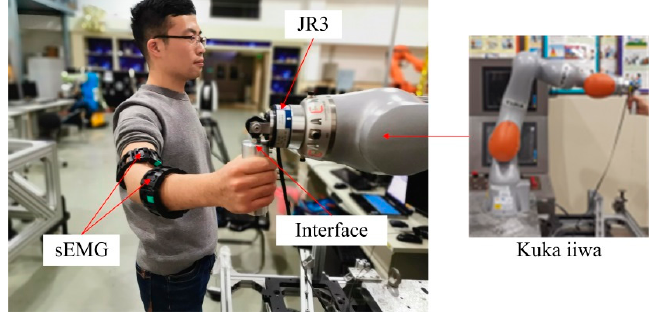
Figure 6. Experimental system of stiffness identification.